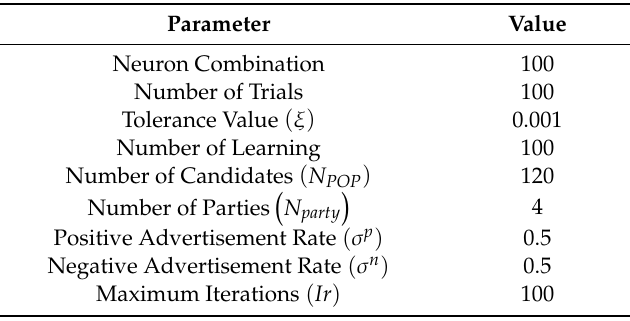
Table 3. List of parameters used in Hopfield Neural Network-Random 2 Satisfiability Election Algorithm